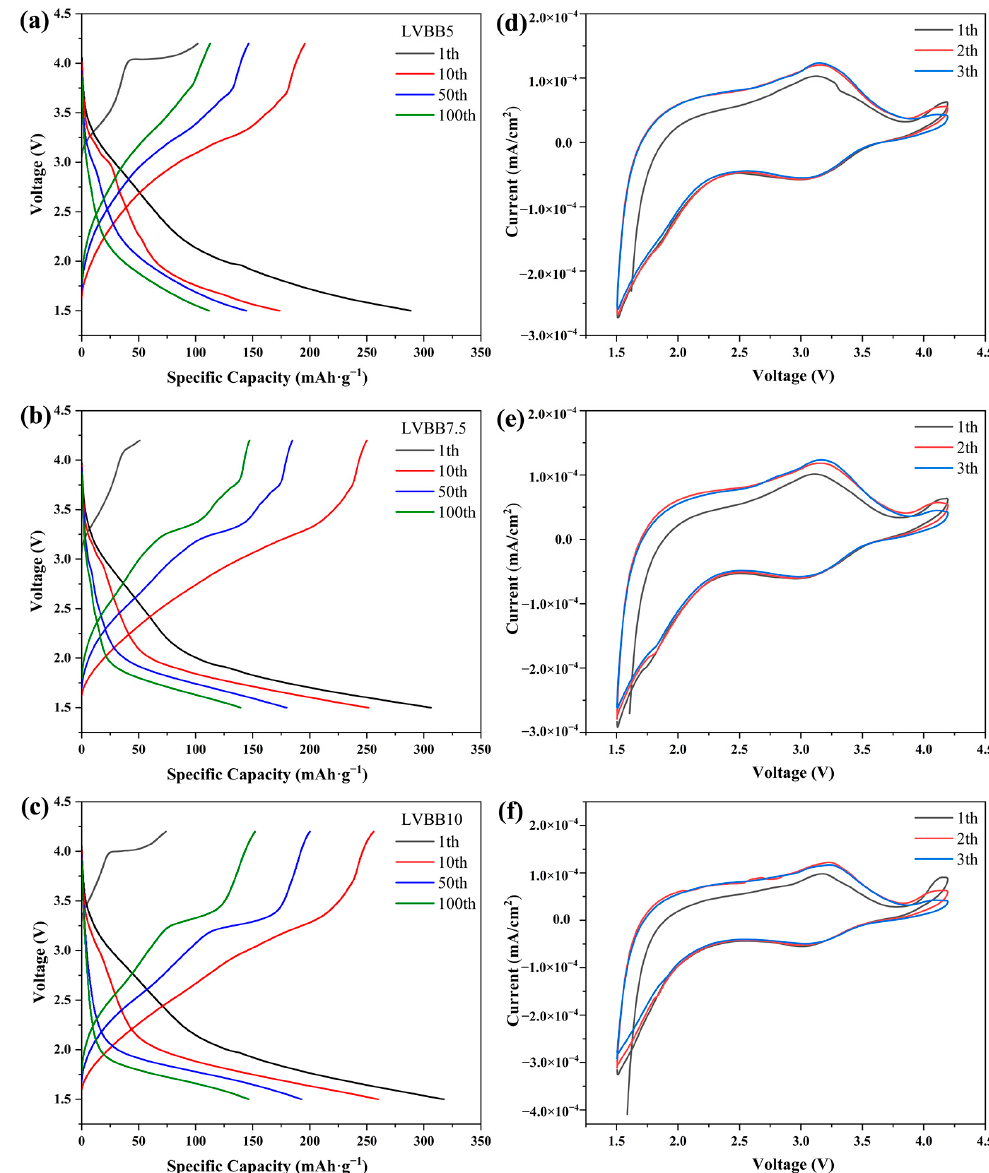
Figure 3. Charge and discharge curves at 50 mA·g − 1 of ( a ) LVBB5, ( b ) LVBB7.5 and ( c ) LVBB10 in the voltage range of 1.5–4.2 V; CV curves of ( d ) LVBB5, ( e ) LVBB7.5 and ( f ) LVBB10 in the potential window of 1.5–4.2 V with a scanning rate of 0.2 mV·s − 1 .